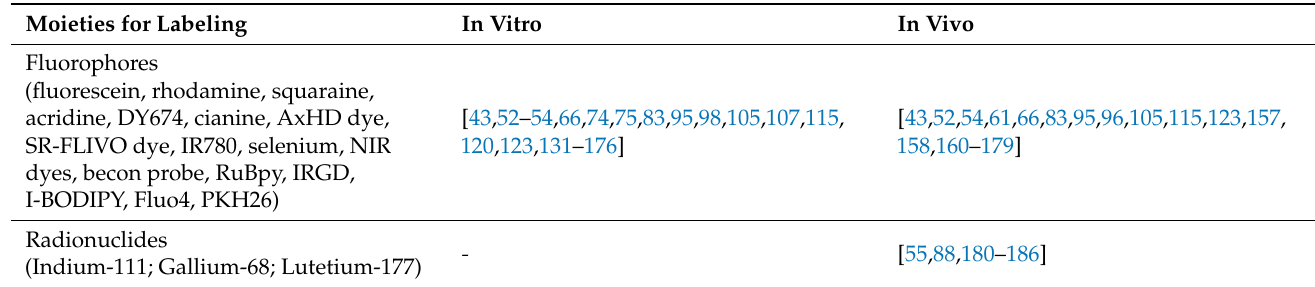
Table 2. Moieties for labeling. NPs can be functionalized with labeling moieties allowing both in vitro and in vivo NP tracking